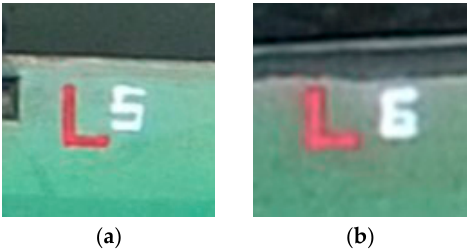
Figure 5. Two ground control points (GCPs) on a barge: ( a ) a GCP numbered 5; ( b ) a GCP numbered 6.